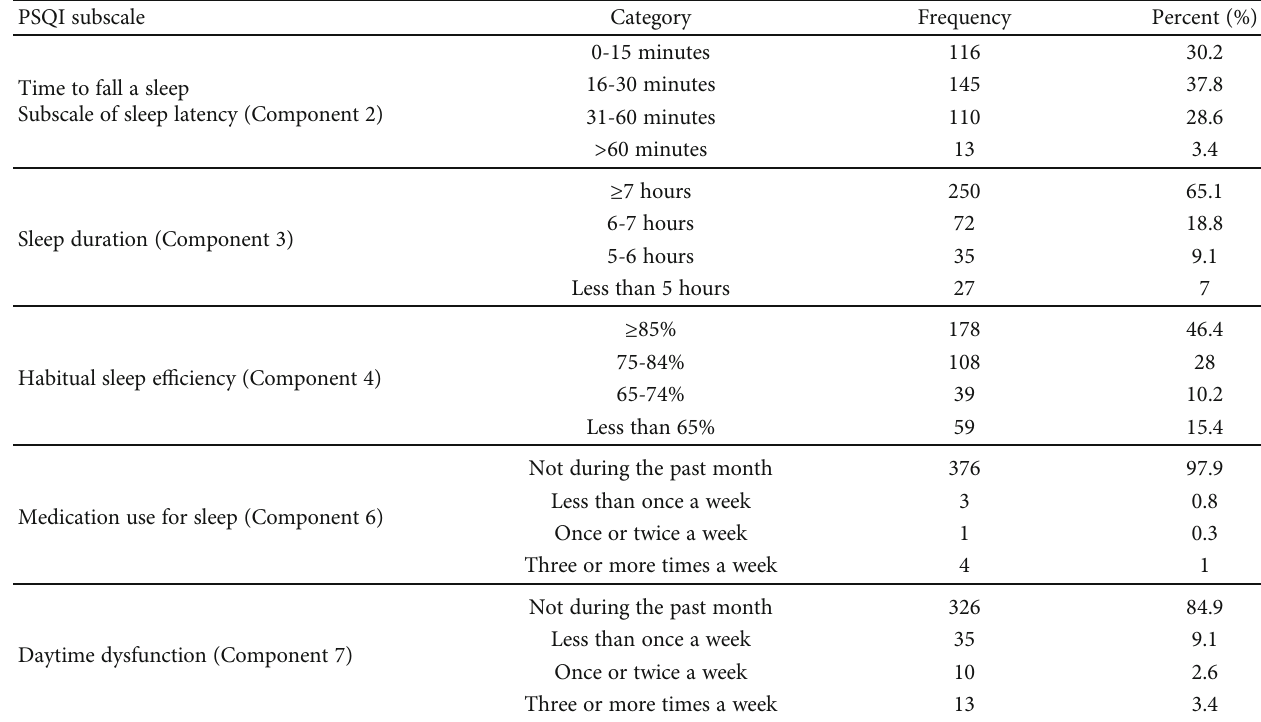
Figure 1: Rate of overall subjective sleep quality among patients with chronic illness at Debre Markos Referral Hospital Chronic Illness Follow-up Clinic, 2018. Table 3: The Pittsburgh Sleep Quality Index (PSQI) subscale scores and level of sleep quality among diabetes, hypertension, and heart failure patients at Debre Markos Referral Hospital Chronic Illness Follow-up Clinic, 2018 ( N = 384